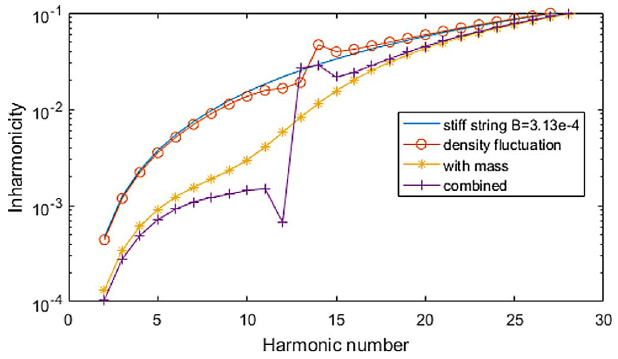
Figure 5. Inharmonicity as a function of harmonic number for a string of length L = 1 m and with a linear density l = 180 g/m . Blue curve: string alone with B = 3.13 (cid:3) 10 (cid:2) 4 . Red curve: string ¼ 0 : 14 and with sinusoidal density fl uctuations such that (cid:1) l s l 0 b = 7.5 cm (see Appendix). Yellow curve: string with a mass m = 3.5 g at a = 2.4 cm from the end. Purple curve: string with a mass ( m = 3.5 g and a = 2.4 cm) and sinusoidal density fl uctuations ( (cid:1) l s ¼ 0 : 14 and b = 7.5 cm). l 0